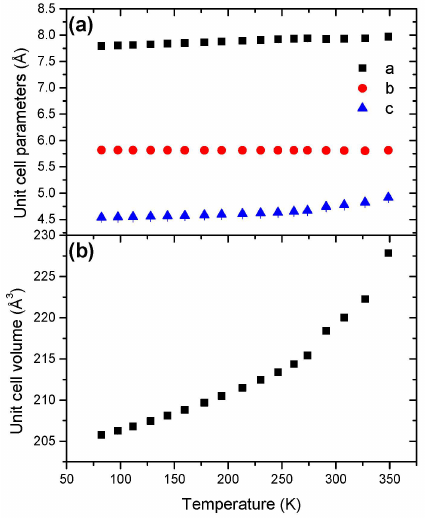
Figure 12. Temperature dependence of ( a ) the unit cell parameters and ( b ) the unit cell volume for STB in the temperature range 81–349